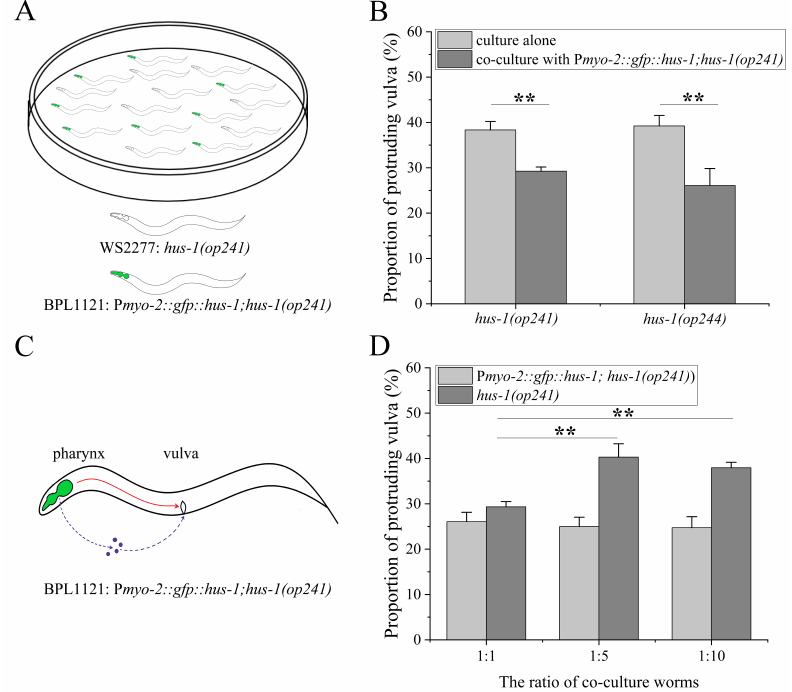
Figure 3. Inter-individual regulation of pharyngeal ATR cascade on vulval radiosensitivity: ( A ) the schematic diagram of co-culture experimental system of worms, in which BPL1121: P myo-2::gfp::hus-1; hus-1(op241) and hus-1 worms are distinguished according to GFP fluorescence in the pharynx; ( B ) the vulval radiosensitivity of hus-1(op241) and hus-1(op244) worms co-cultured with BPL1121 worms; ( C ) two possible transmitting/cascading modes of pharynx-derived damage signals in BPL1121 worms, represented schematically by the red line and dotted blue lines, respectively; ( D ) the vulval radiosensitivity of hus-1 worms co-cultured with BPL1121 worms at the indicated ratios. Results are means ± SD ( n ≥ 3, t -test, ** p <